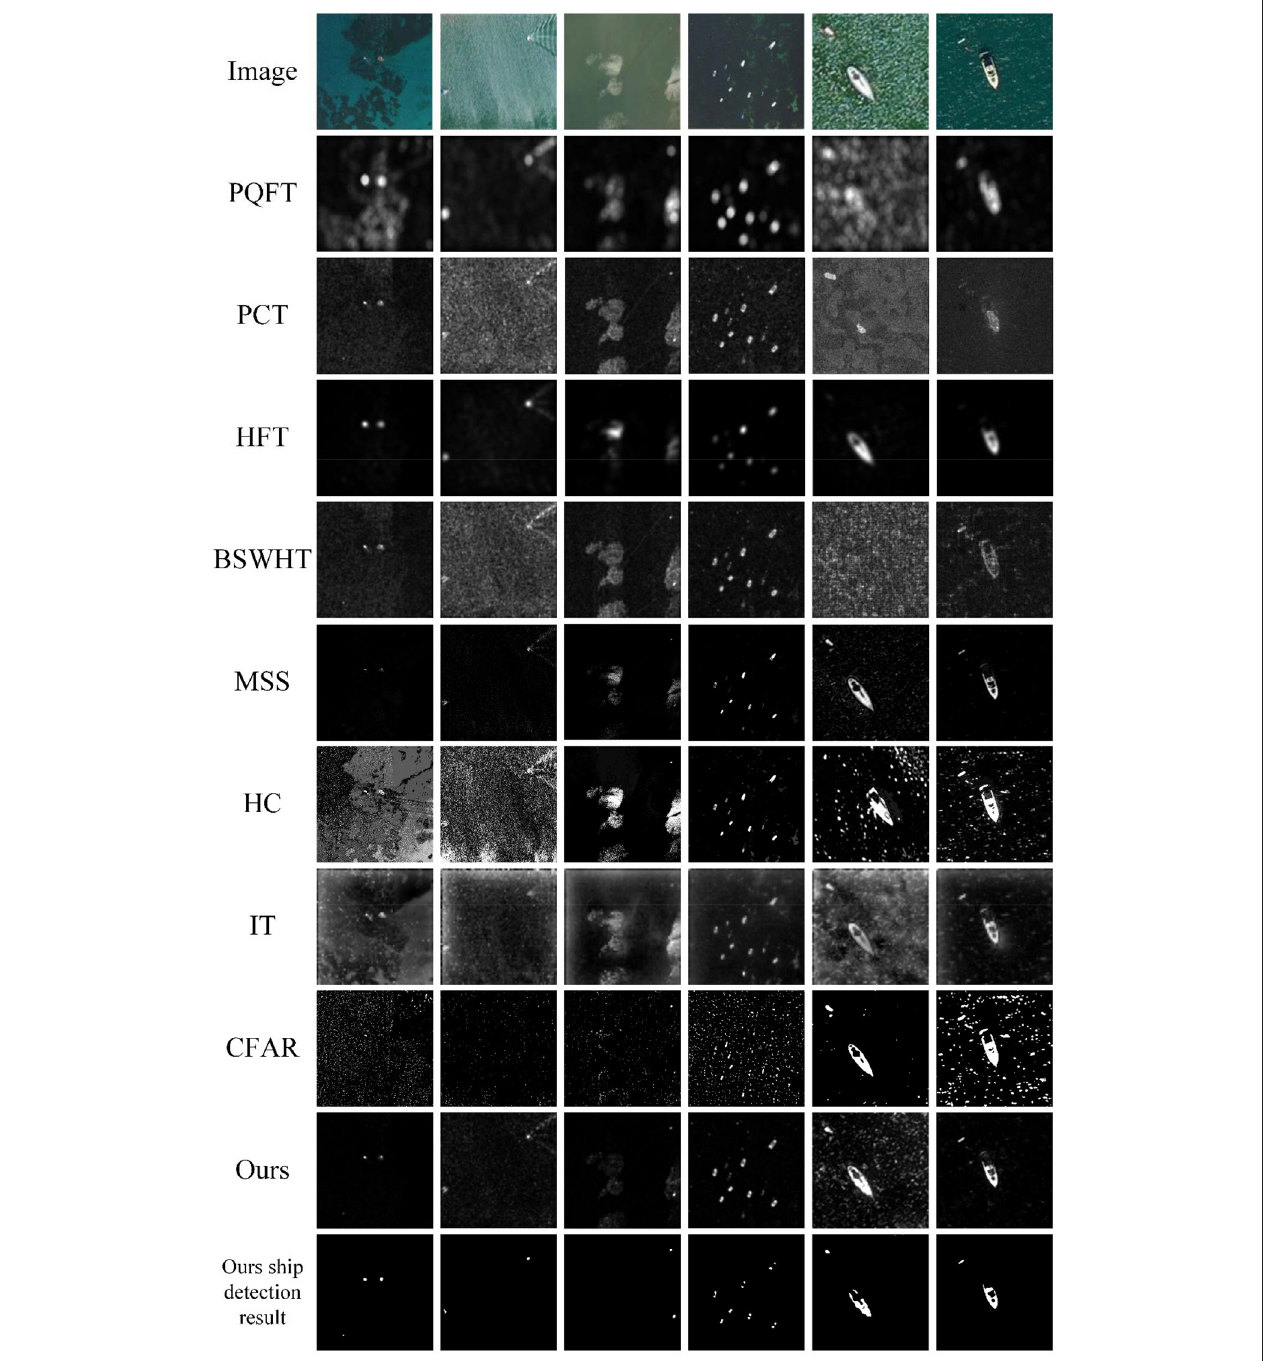
FIGURE 7 | A visual comparison of the saliency maps obtained by all eight approaches, as well as the detection results of CFAR and our method for the MASATI images with multiple ships.